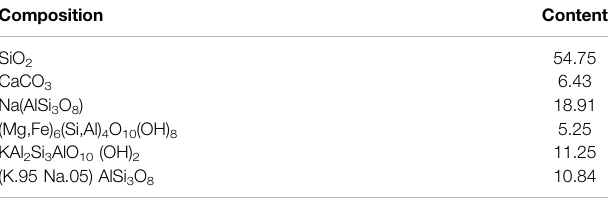
TABLE 2 | Mineral content of loess in Lishi area (%).